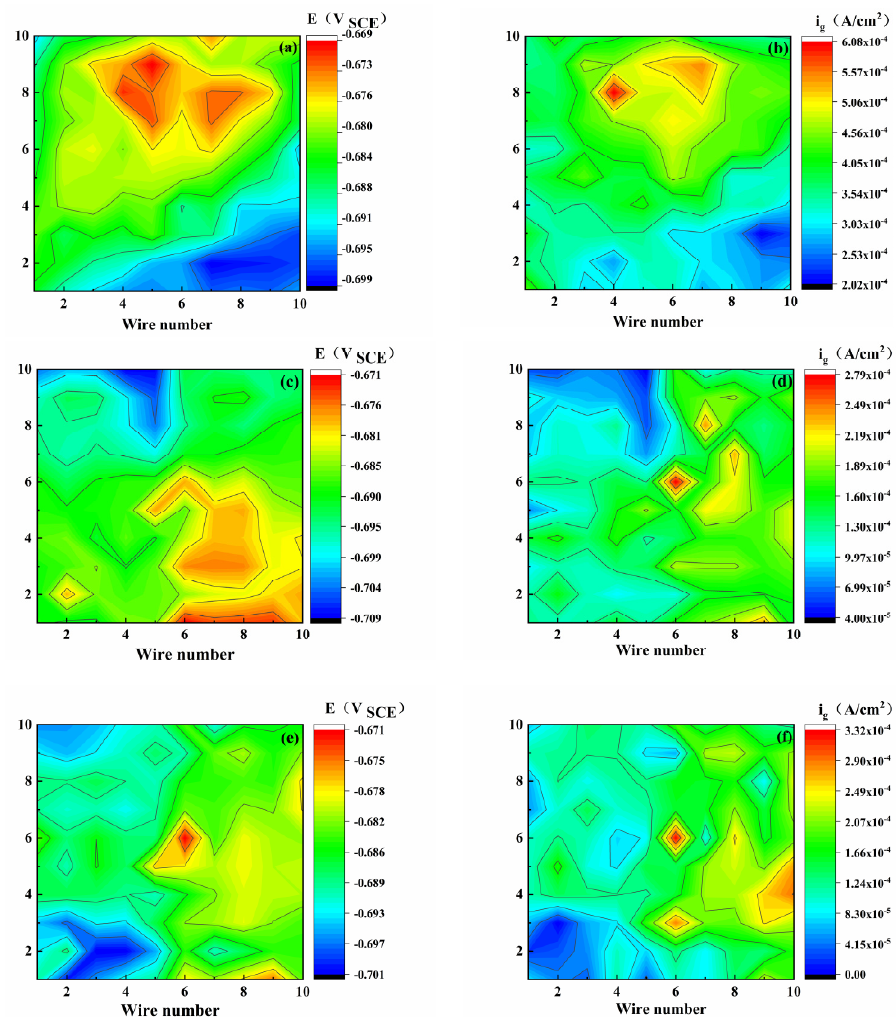
Figure 3. Potential (E) and galvanic current density (ig) distribution maps of WBE bare electrode at different pH values (( a , b ): pH 3.10), (( c , d ): pH 5.15), (( e , f ): pH 7.18).